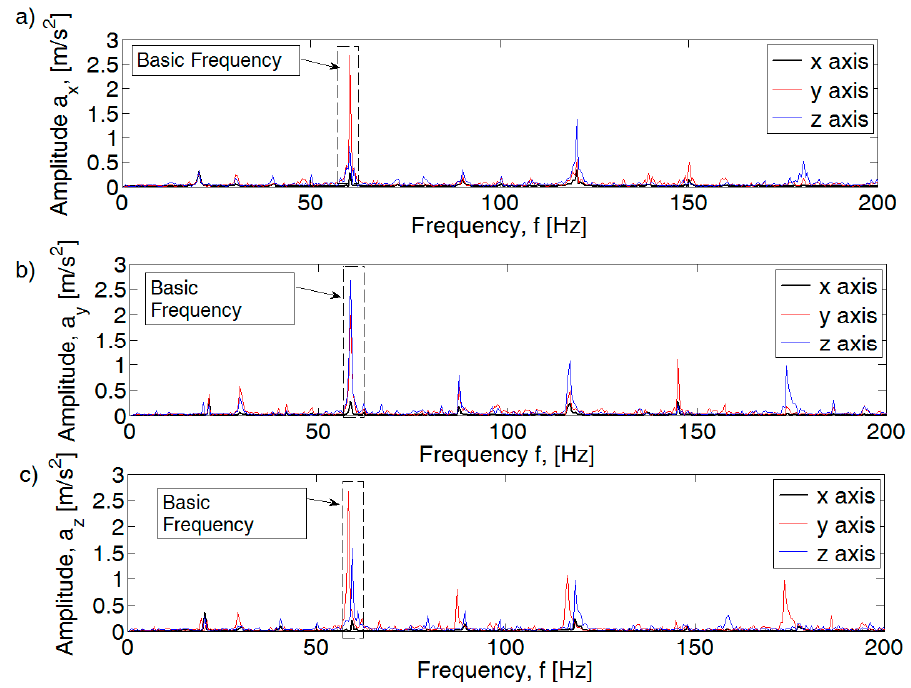
Figure 8. FFT spectral amplitude for 3500 rpm combustion engine: ( a ) efficient, ( b ) injection inefficient, and ( c ) pressure inefficient.